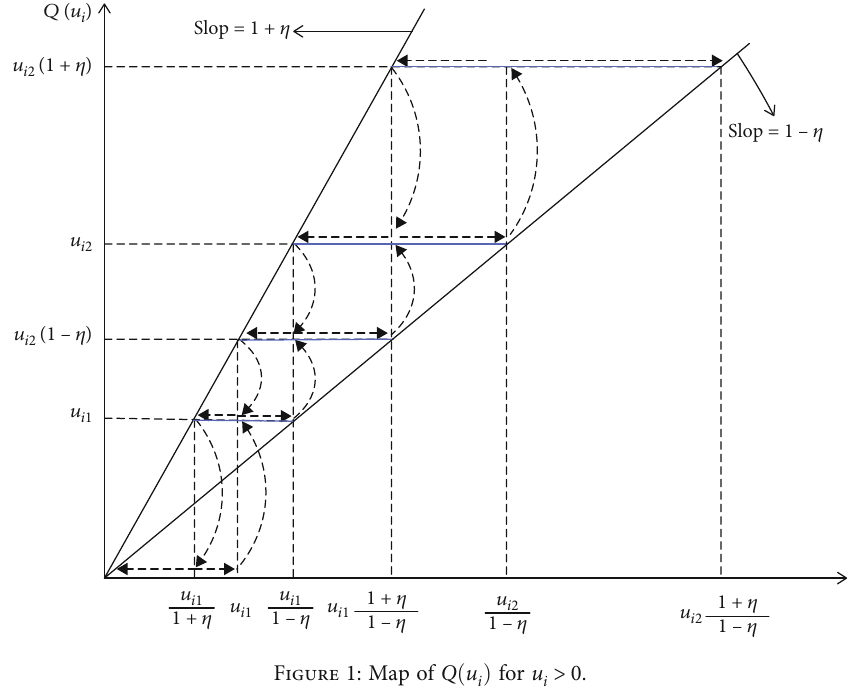
Figure 1: Map of Q ð u